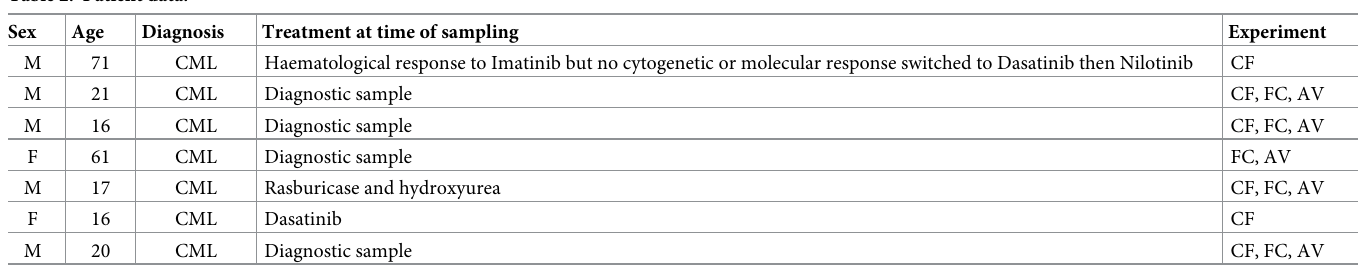
Table 2. Patient data.